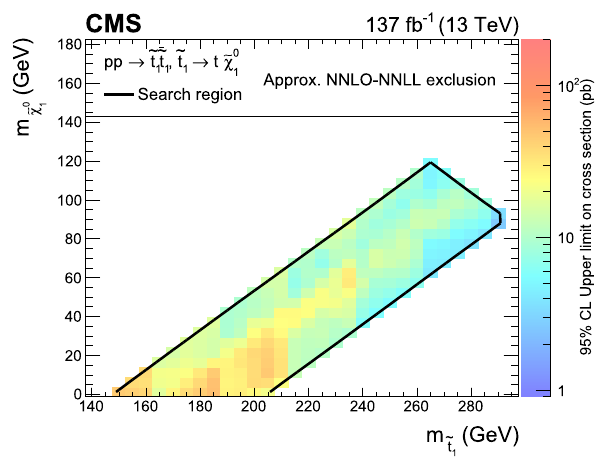
Fig. 7 Upper limit at 95% CL on the signal cross section as a function of the top squark and neutralino masses in the top quark corridor region. The model is excluded for all of the colored region inside the black boundary